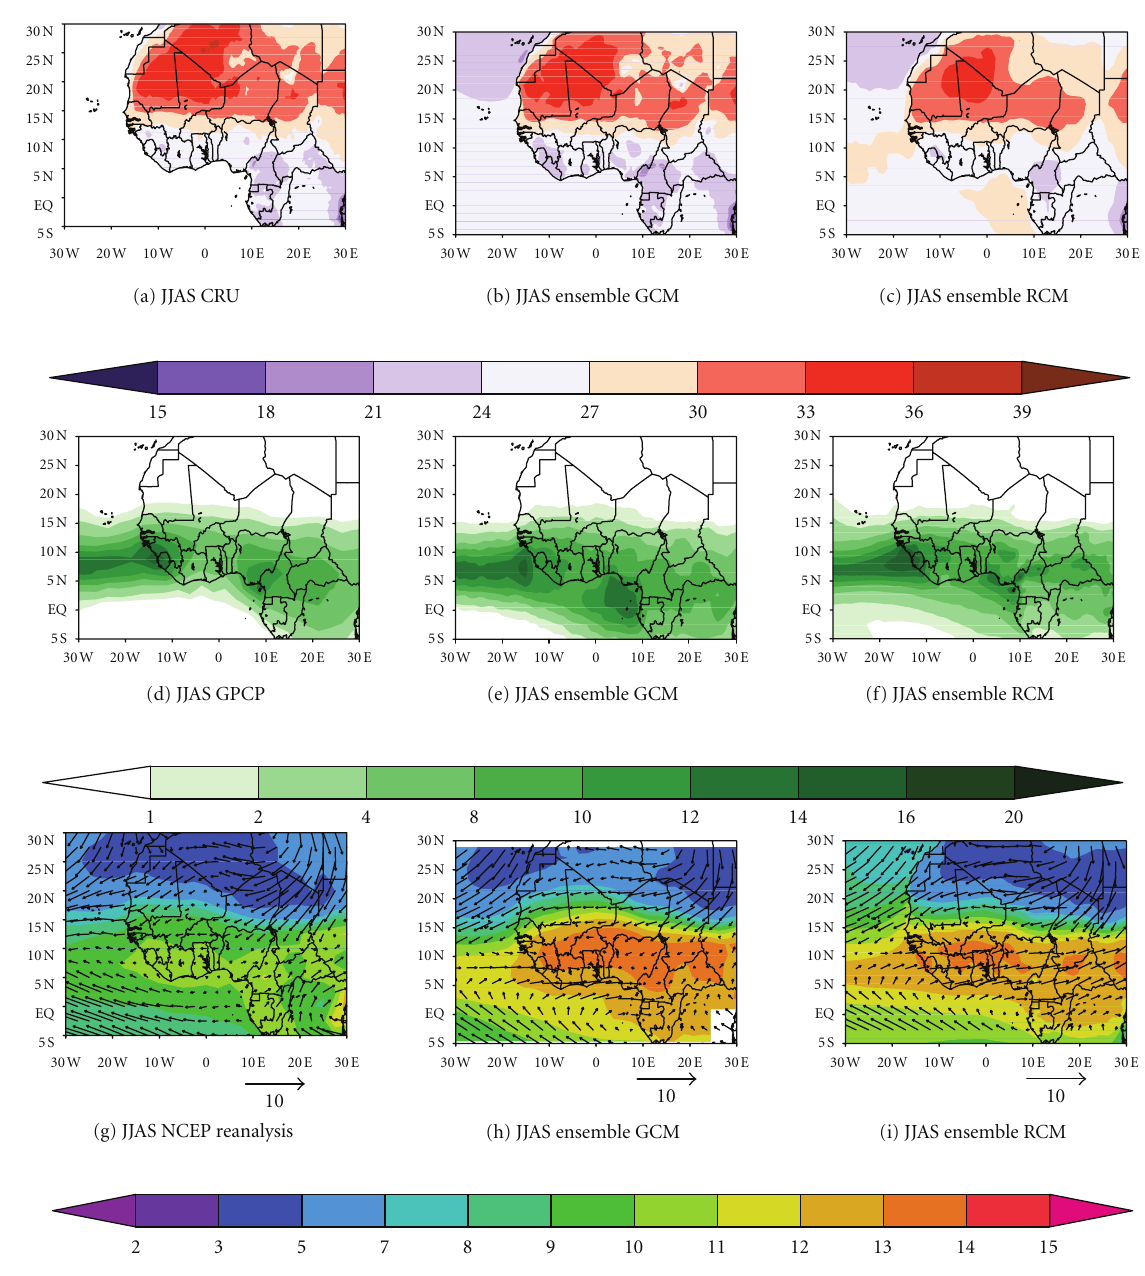
Figure 7: 1981–2000 averaged JJAS of temperature (top panel, in ◦ C), precipitation (middle panel, mm/day), and specific humidity (shaded; in g/kg; bottom panel) with superimposed wind vector (in m/s) from: (a) CRU observation, (b) mean ensemble of GCMs, (c) multi-model ensemble of the four RCMs, (d) GPCP observation, (e) mean ensemble of GCMs, (f) multi-model ensemble of the four RCMs, (g) NCEP reanalysis, (h) mean ensemble of GCMs, and (i) multi-model ensemble of the four